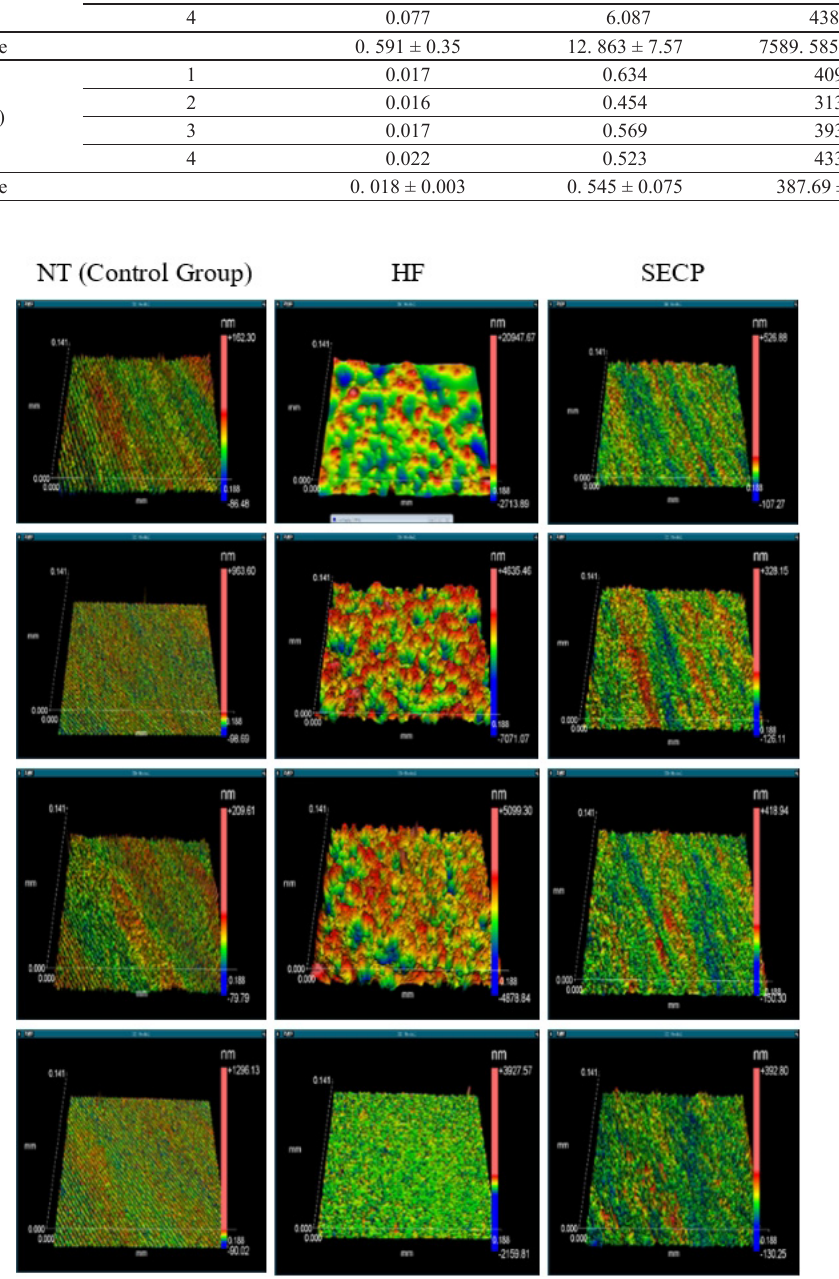
Figure 6. 3D roughness profile of the sample surfaces: Left - control group - no treatment (NT); Middle - after hydrofluoric acid etching (HF) and, Right - pre-treatment with Monobond Etch and Prime